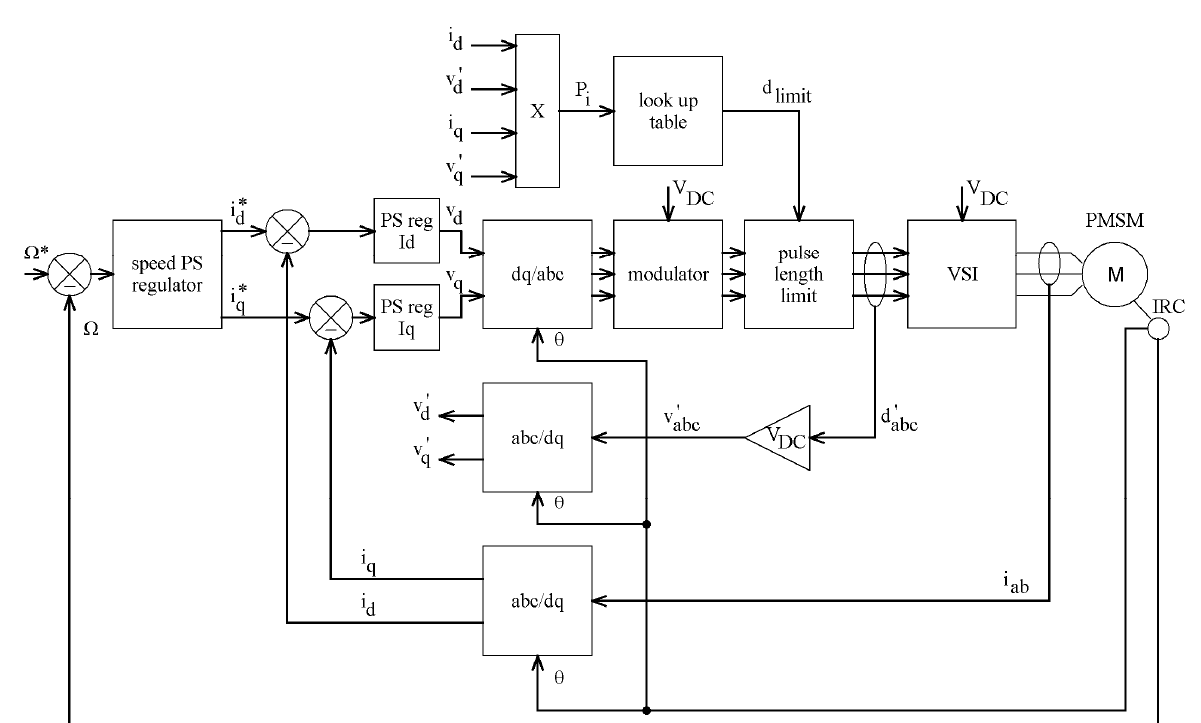
Figure 7. PMSM control scheme with added LUT-based pulse length limitation block. The values modified by the pulse-limiting algorithm are primed.